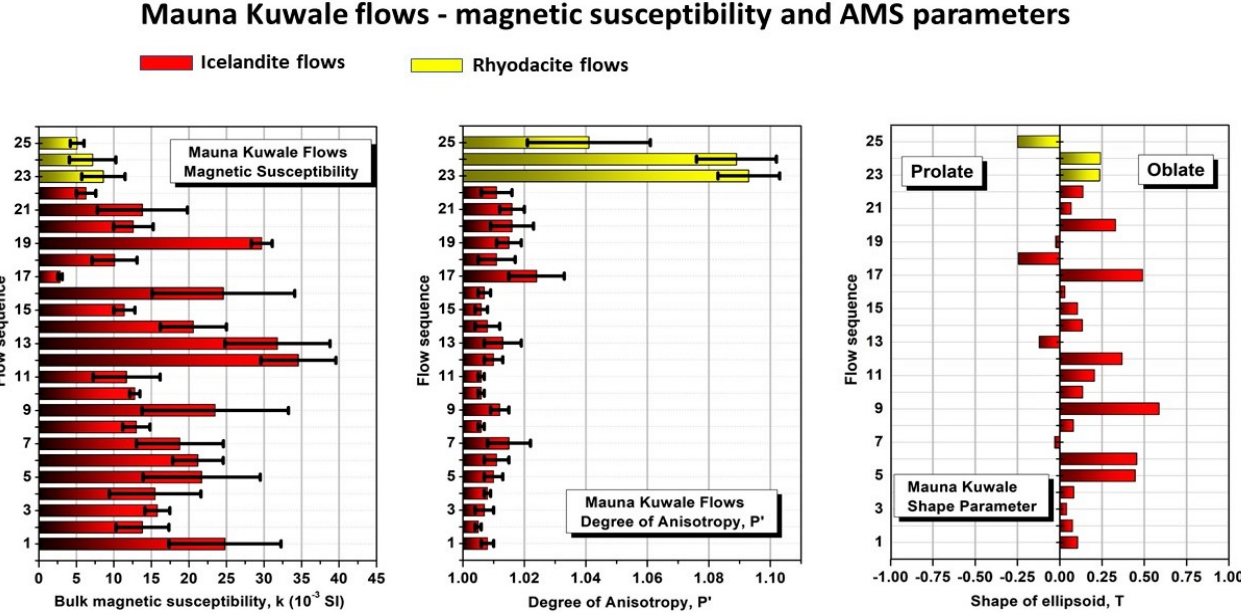
Figure 2. ( left ) Mean magnetic susceptibility of the flows in 10 − 3 SI units; ( middle ) magnetic degree of anisotropy, parameter P’; ( right ) shape of ellipsoid, T. Notice the Icelandite cooling units in red and Rhyodacite cooling units in